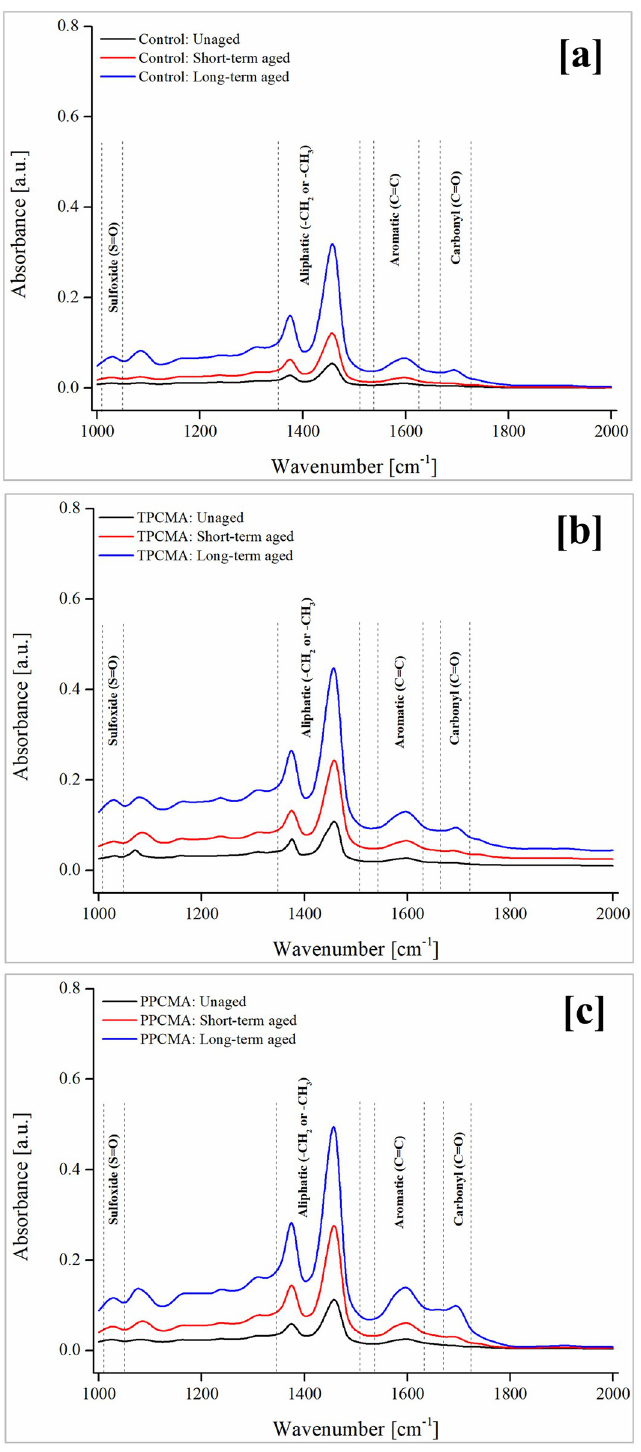
Fig 12. FTIR spectra under different aging state (a) Control (b) TPCMA (c) PPCMA.